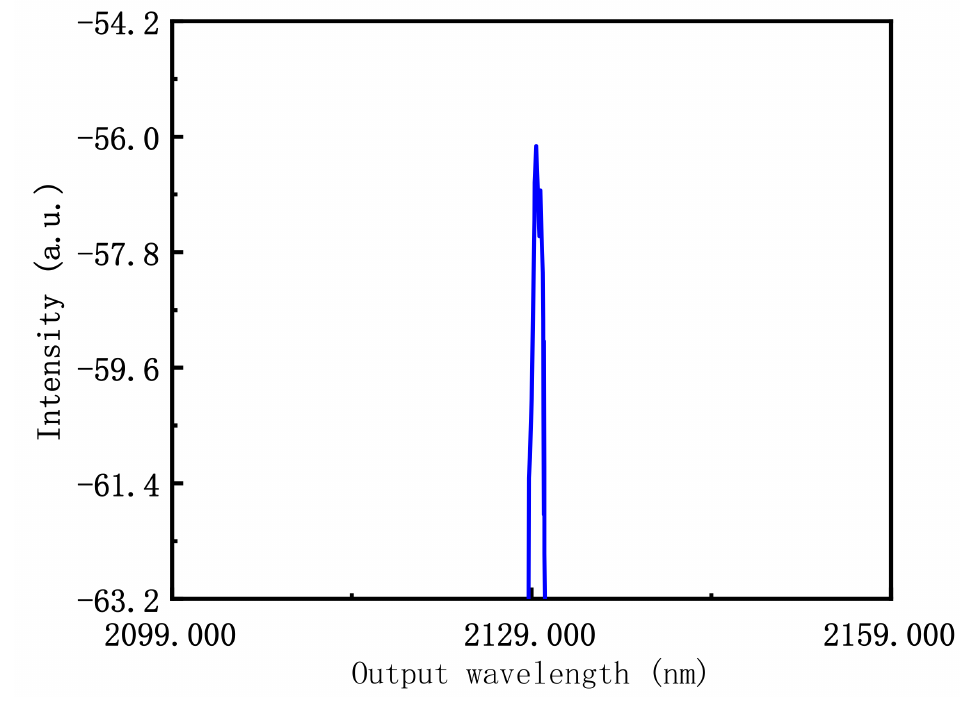
Figure 7. Output spectrum of AO Q-switched Ho:YAP laser.